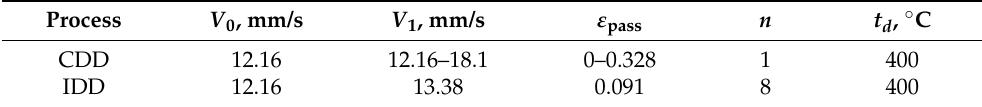
Table 1. The experimental conditions of the DD processes. Process